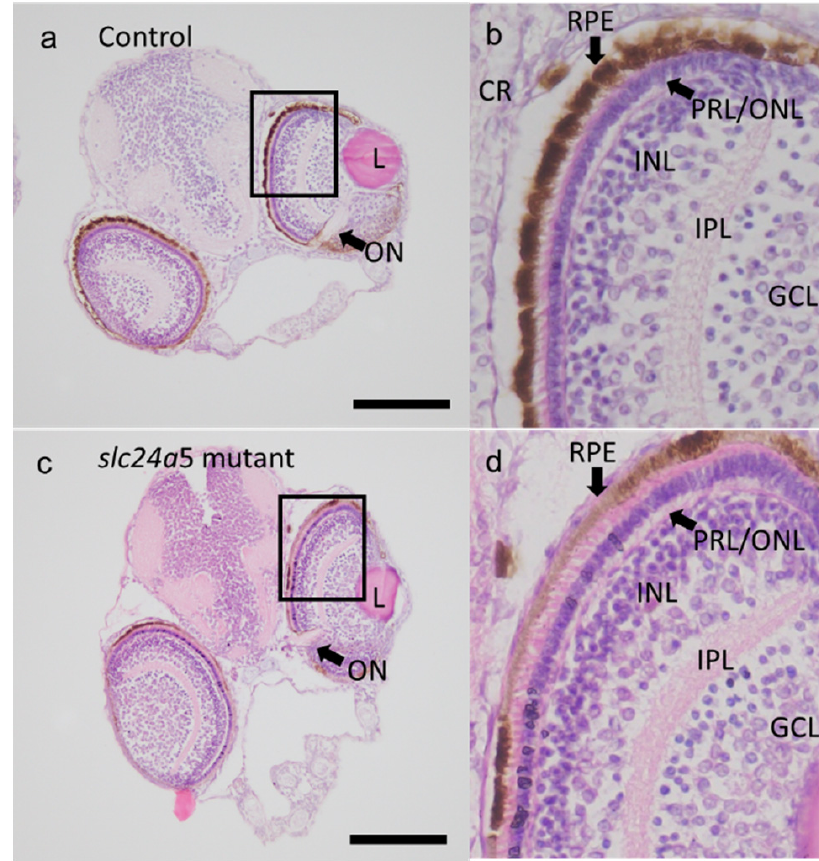
Figure 6. Histological section of kawakawa eyes in the slc24a5 mutant at 72 hpf. A cross section of the head in control larva ( a , b ) and slc24a5 mutant larva ( c , d ). The regions shown in ( a , c ) are enlarged in ( b , d ), respectively. Control larva showed completely dark RPE with melanin pigmentation, while much lighter RPE without melanin pigmentation was seen in the slc24a5 mutant. RPE: retinal pigment epithelium; PRL/ONL: photoreceptor layer/outer nuclear layer; INL: inner nuclear layer; IPL: inner plexiform layer; GCL: ganglion cell layer; L: lens, ON: optic nerve; CR: choroid rete. Scale 100 µm.